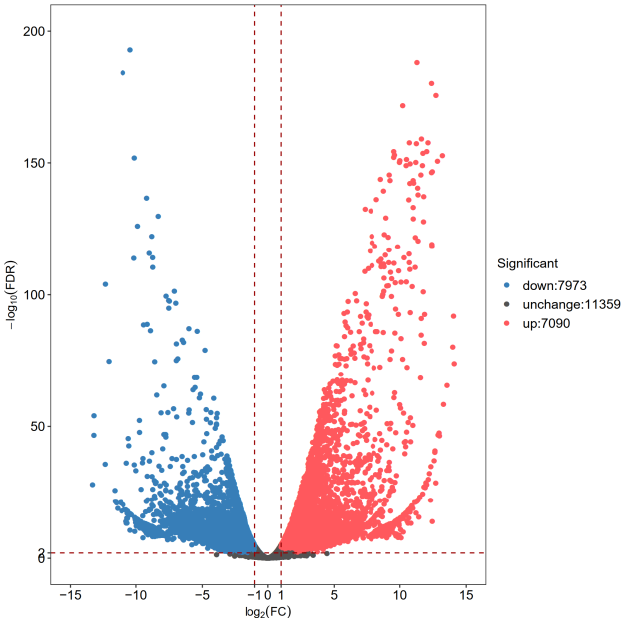
Figure 2. Volcano plot of the DEGs in the gonadal tissues of male and female Andrias davidianus . DEGs in females compared to males. Blue dots indicate upregulated DEGs in males compared to females. Red dots indicate upregulated DEGs in females compared to males. The cut-off of the ordinate indicates a fold change (FC) of 2 and the cut-off of the abscissa indicates an FDR of